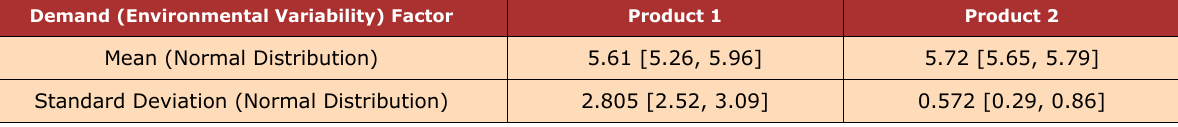
Table 15. Case-1 boundary conditions used in creating LHS samples